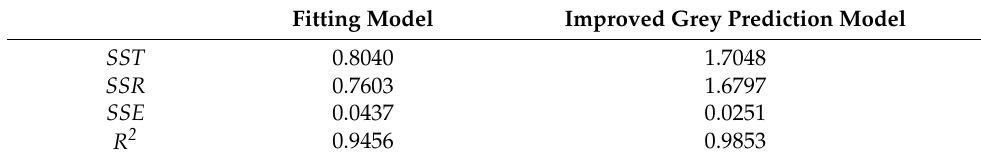
Table 4. Test results of the